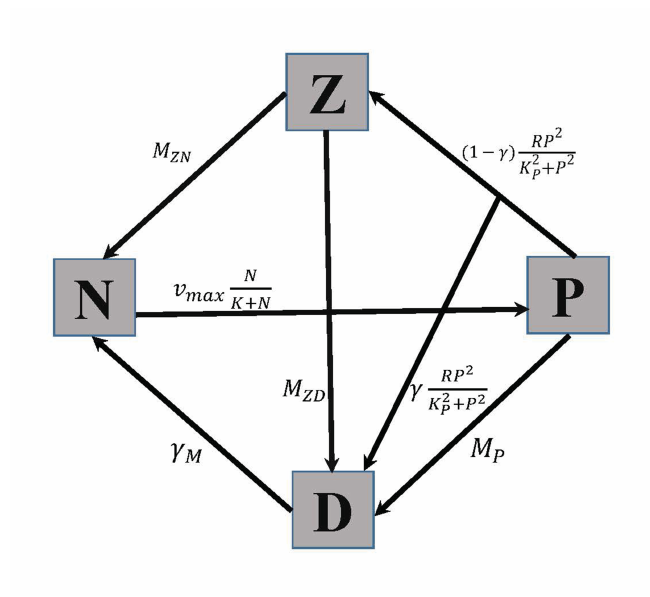
Figure 1. Schematic diagram of energy flow-up in the NPZD system